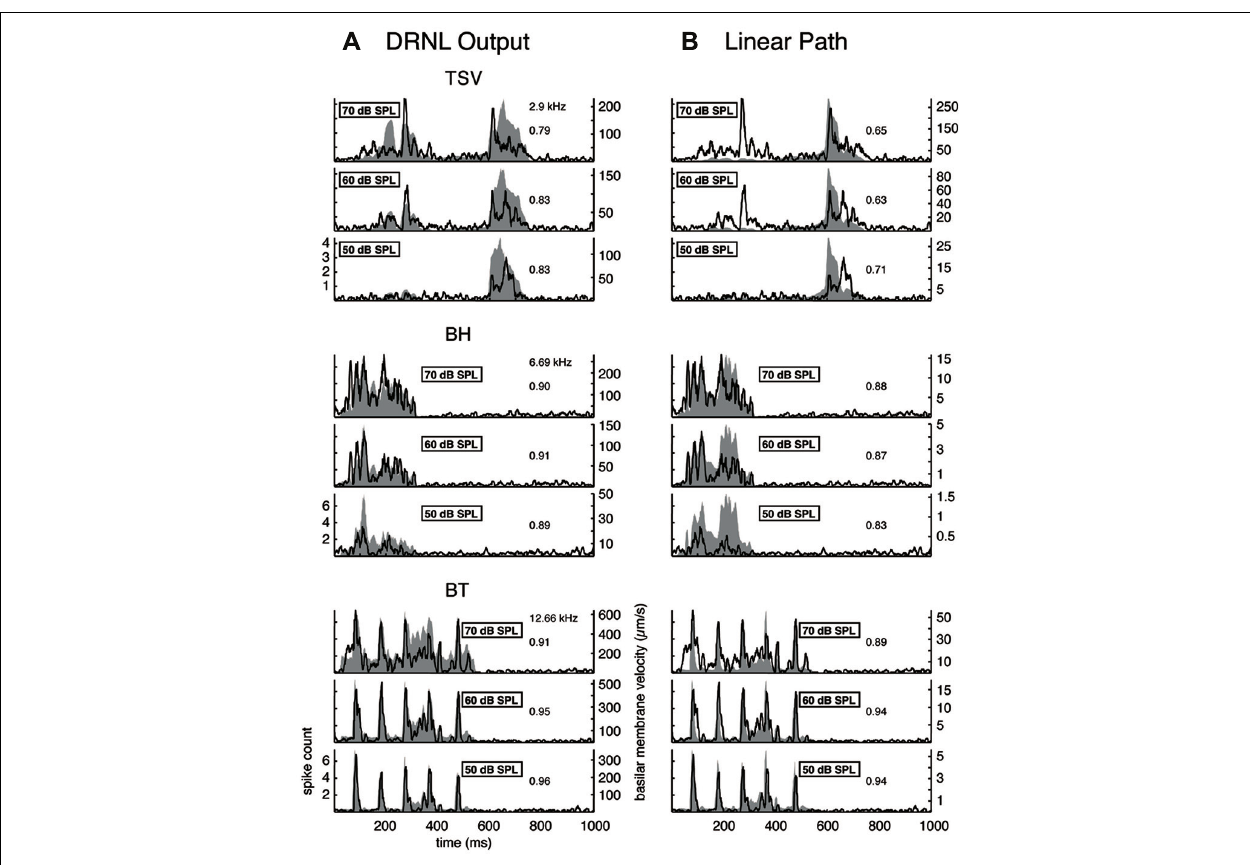
FIGURE 9 | Comparison of DRNL output versus the linear path output. The PSTH responses are plotted for three different levels along with the DRNL output (A) and the linear path component of the DRNL model (B) for all three